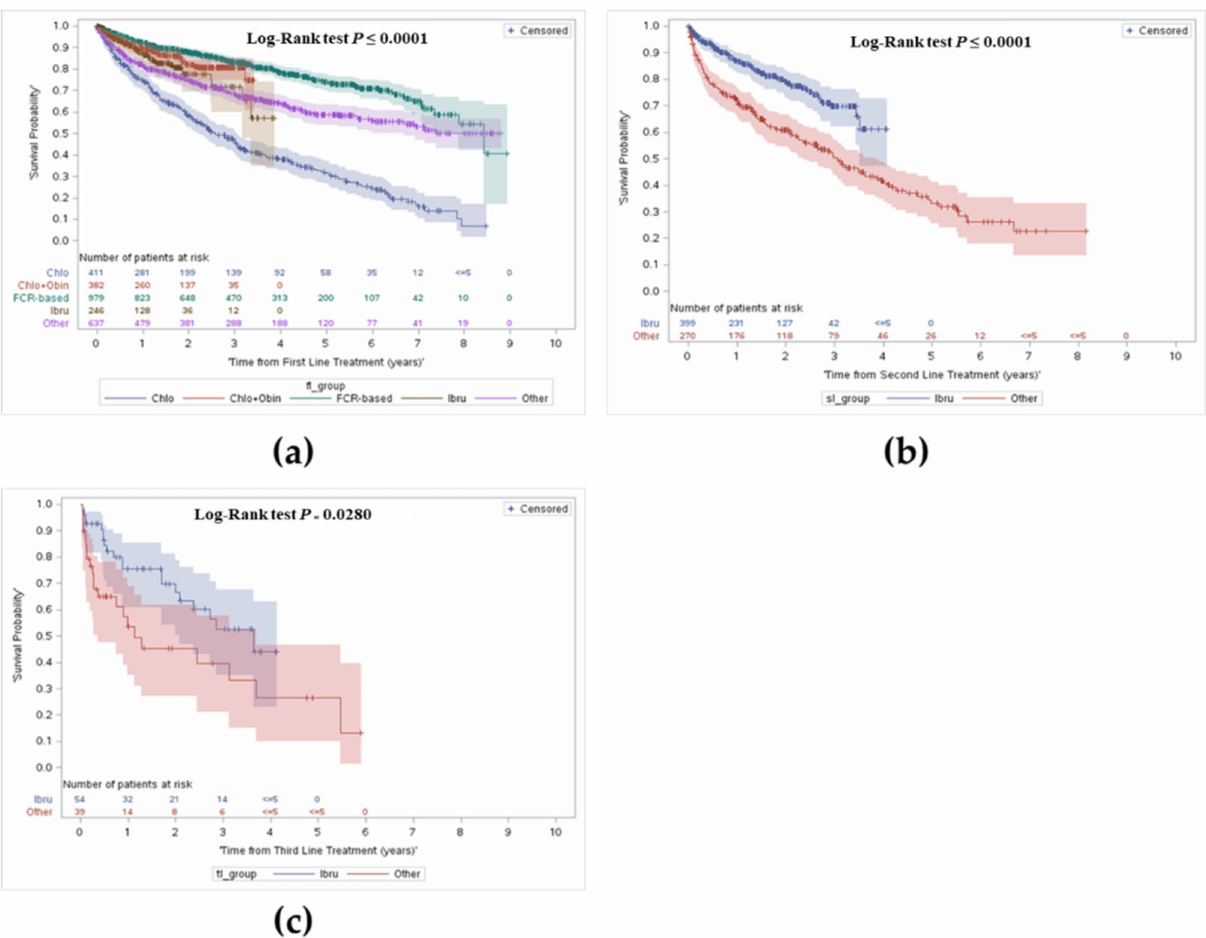
Figure 3. Overall survival from first, second and third line treatment stratified by type of treatment received. ( a ) Over- all survival from first line treatment; ( b ) Overall survival from second line treatment; ( c ) Overall survival from third line